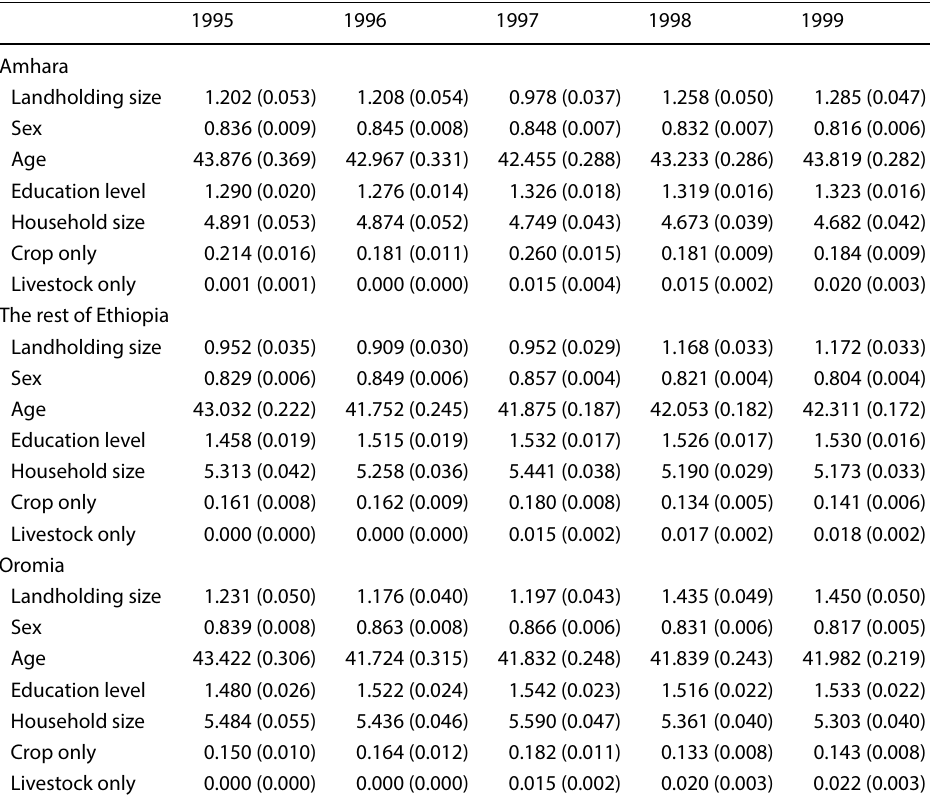
Table 4 Summary statistics by